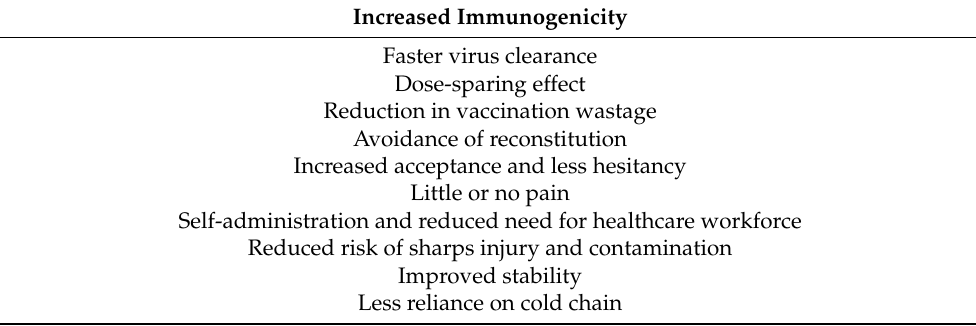
Table 2. Potential advantages of dissolvable microneedle patch vaccine for coronavirus disease 2019